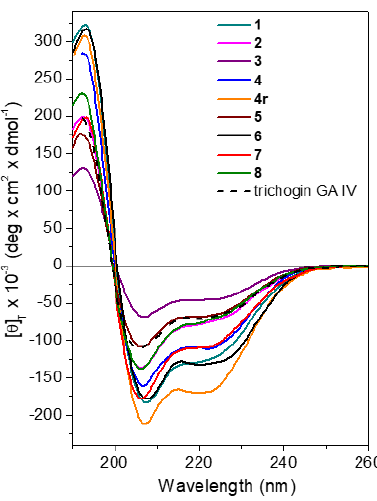
Figure 6. CD profiles recorded for trichogin analogs in SDS 100 mM aqueous solution (peptide concentration: 10 − 4 M). The spectrum of native peptide trichogin GA IV is shown for comparison.